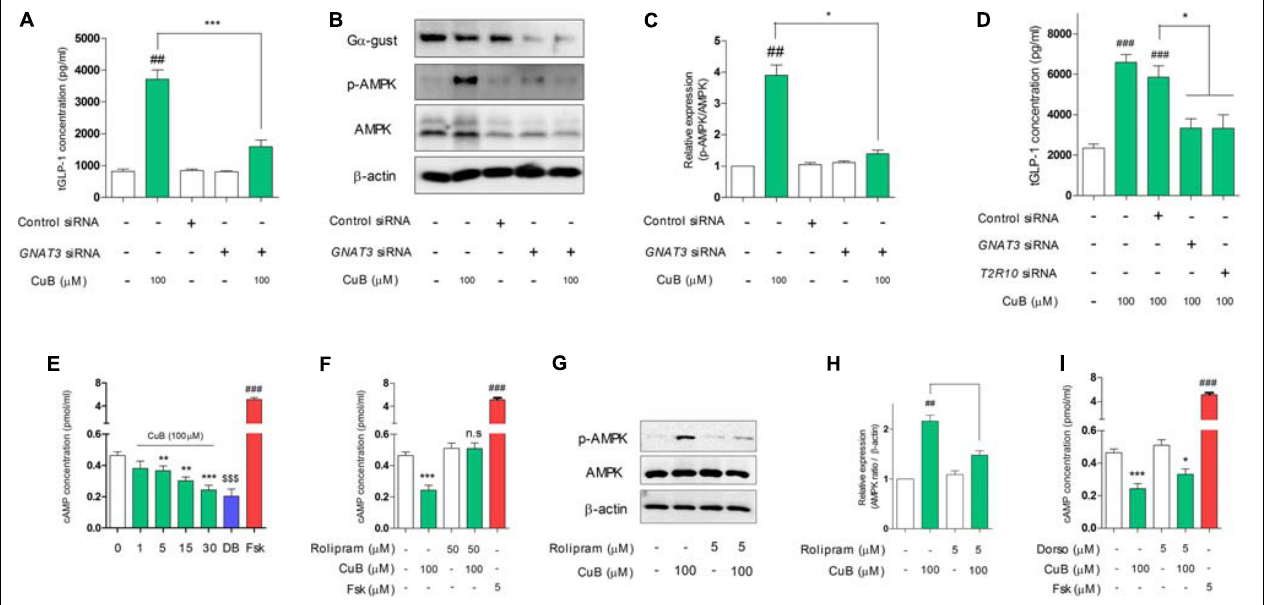
FIGURE 4 | CuB-mediated GLP-1 secretion and activation of AMPK are involved in α -gustducin. (A) The siRNAs of GNAT3 inhibited CuB-mediated GLP-1 secretion in differentiated NCI-H176 cells. Data are presented as a Mean ± SEM, n = 5. ## P < 0.01 vs. control, ∗∗∗ P < 0.001 vs. GNAT3 siRNA + CuB. (B) AMPK expression levels were observed using western blotting under knock down condition of GNAT3 . (C) The knock down of GNAT3 prevented CuB-mediated activation of AMPK in differentiated NCI-H716. Data are presented as a Mean ± SEM, n = 5. ## P < 0.01 vs. control, ∗ P < 0.05 vs. GNAT3 siRNA + CuB. (D) The transfection of GNAT3 , TAS2R10 , and TAS2R14 siRNA caused to inhibit CuB-mediated GLP-1 secretion in differentiated NCI-H176 cells. Data are presented as a Mean ± SEM, n = 5. ## P < 0.01 vs. control, ∗∗ P < 0.01, ∗∗∗ P < 0.001 vs. Control siRNA. (E) CuB treatment led to time-dependently decrease intracellular cAMP. Data are presented as a Mean ± SEM, n = 8. ### P < 0.001 (Frs) vs. control, ∗∗ P < 0.01, ∗∗∗ P < 0.001 (CuB) vs. control, $$$ P < 0.001 (DB) vs. control. (F) CuB-mediated decreasing intracellular cAMP concentration restored by treatment of PDE4D inhibitor (Rolipram, 50 µ M). Data are presented as a Mean ± SEM, n = 8. ### P < 0.001 vs. Fsk, ∗∗∗ P < 0.001 (CuB) vs. control. (G) AMPK expression levels were observed using western blotting under treatment of rolipram. (H) Rolipram treatment prevented CuB-mediated activation of AMPK in differentiated NCI-H716. Data are presented as a Mean ± SEM, n = 5. ## P < 0.01 vs. control, ∗ P < 0.05 vs. Rolipram +